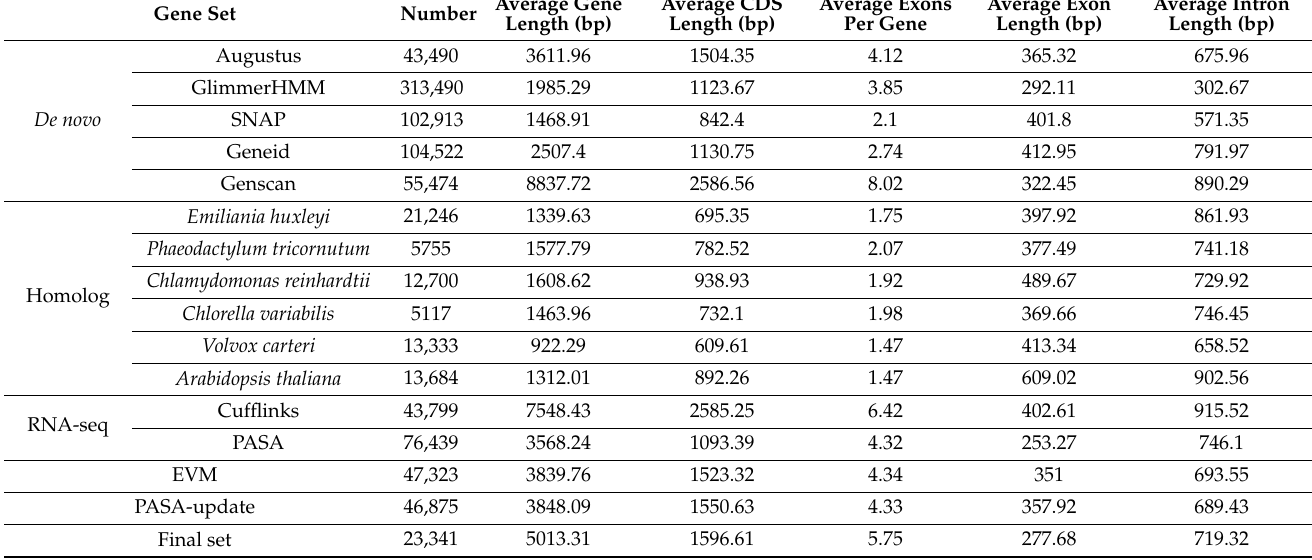
Table 6. Basic statistical results of gene structure prediction of C. roscoffensis